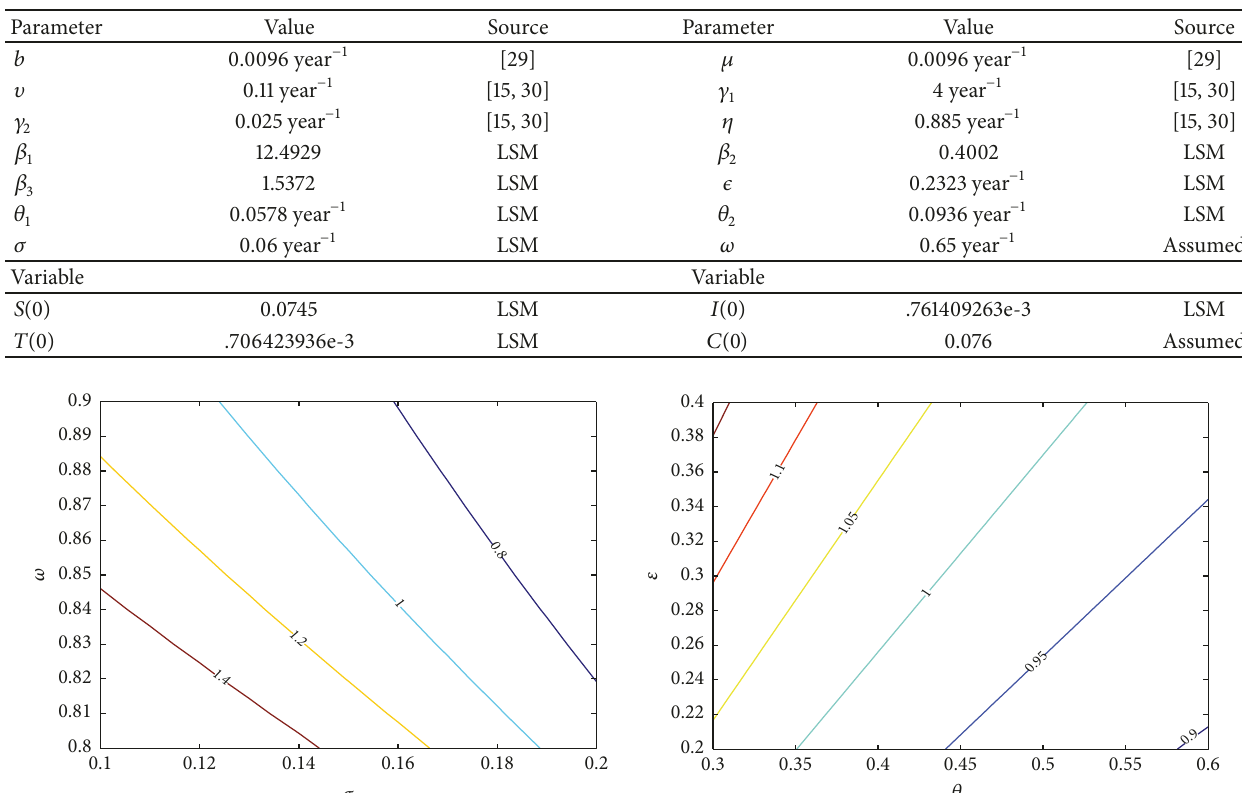
Table 3: List of parameters and initial values used in simulation.